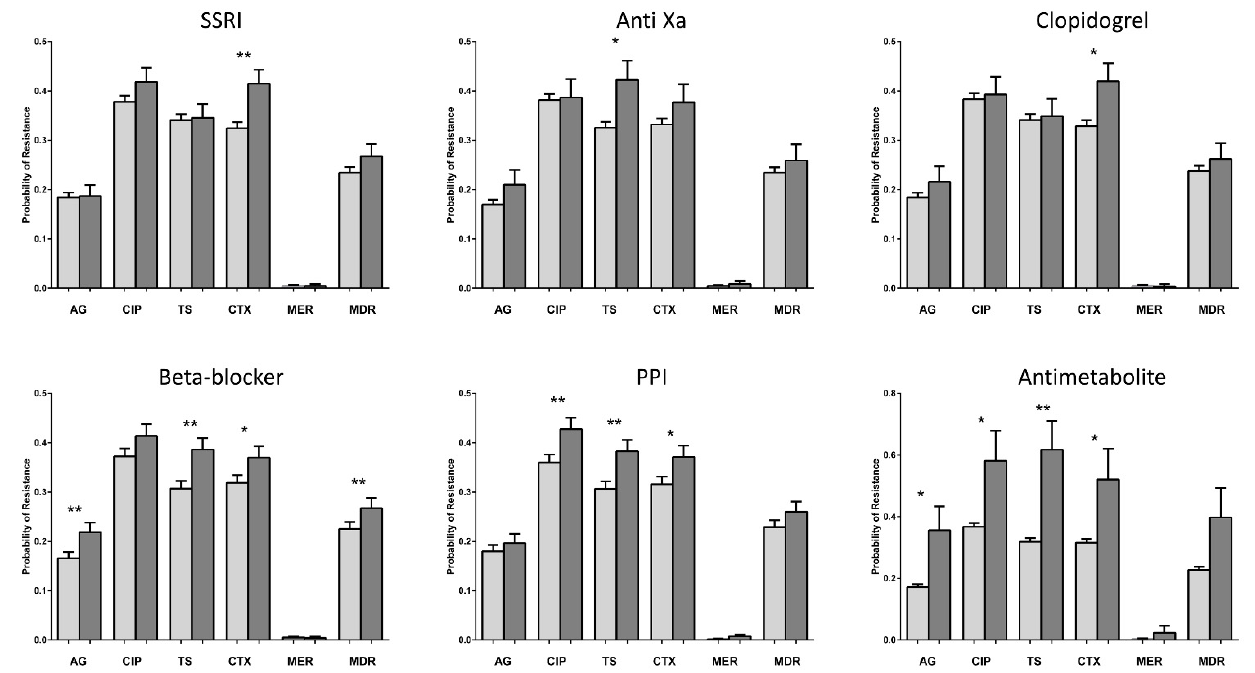
Figure 2. Treatment effects model of antimicrobial resistance and non-antimicrobial drug exposure. Bars represent odds of infection with an organism expressing the resistance phenotype calculated from the treatment effects model (see Methods). Error bars represent the 95% confidence interval. SSRI: selective serotonin reuptake inhibitor; PPI: proton pump inhibitor; AG: aminoglycoside; CIP: ciprofloxacin; TS: trimethoprim-sulfamethoxazole; CTX: ceftriaxone; MER: meropenem; MDR: multidrug resistant organism. * p < 0.05; ** p < 0.01.